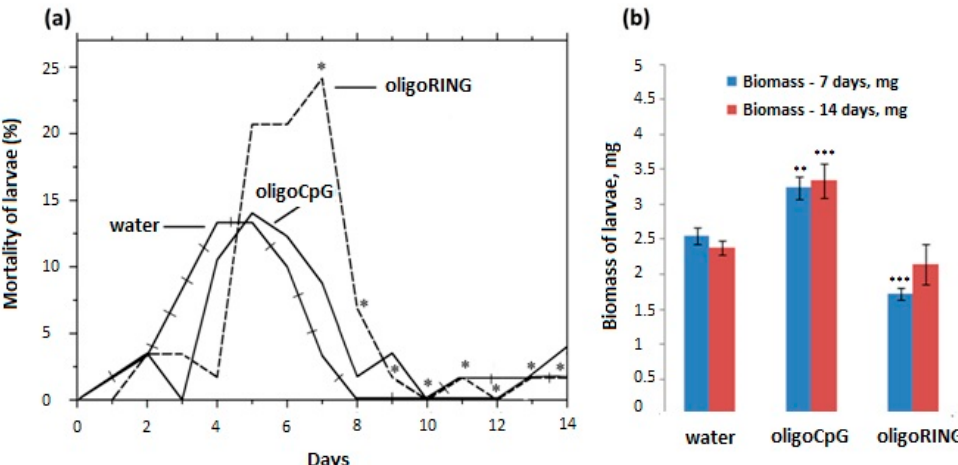
Figure 4. The oligoRING’s effect on the mortality and biomass accumulation of LdMNPV-infected gypsy moth larvae. ( a ) Non-cumulative curve of mortality of LdMNPV-infected larvae after treatment with oligoDNAs. The significant difference is indicated by * for p < 0.05. Each group (water-treated control, oligoCpG, and oligoRING) used 20 to 25 larvae per replicate. Each experiment was conducted in triplicate; ( b ) The mean body mass of LdMNPV-infected larvae after treatment with water, oligoCpG, or oligoRING is shown in mg. SE (standard errors) are given for three replicates. Significant difference: ** for p < 0.01; *** for p < 0.001.